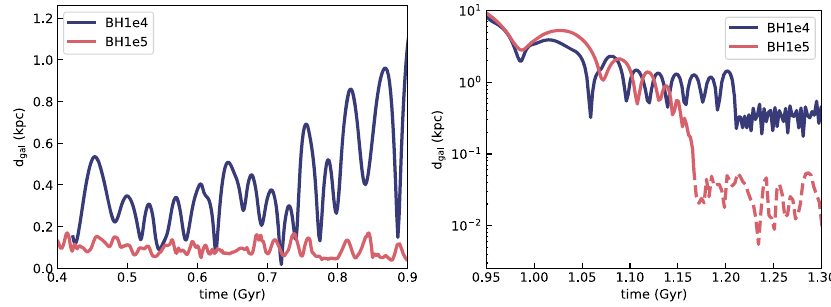
Fig. 19 Distance between an MBH and a galaxy as a function of time for two cosmological simulations which only differ by the mass of the MBHs (10 4 M (cid:3) in blue and 10 5 M (cid:3) in pink). Left: We show the results for the central MBH of the galaxy. In both cases MBHs are smoothly off-centred due to inhomogeneities of the potential, but the more massive one remains in the centre, since dynamical friction is ef fi cient, and the lighter one is instead displaced to kpc distances. Right: We show the results for the central MBH embedded in a satellite galaxy sinking towards the primary galaxy. The initial phase is similar in both cases as the whole satellite suffers dynamical friction, but as soon as material surrounding MBHs has been stripped, the light MBH stalls while the more massive one keeps sinking until it merges with the central MBH of the primary galaxy (subsequent evolution in dashed line). Adapted from P fi ster et al.